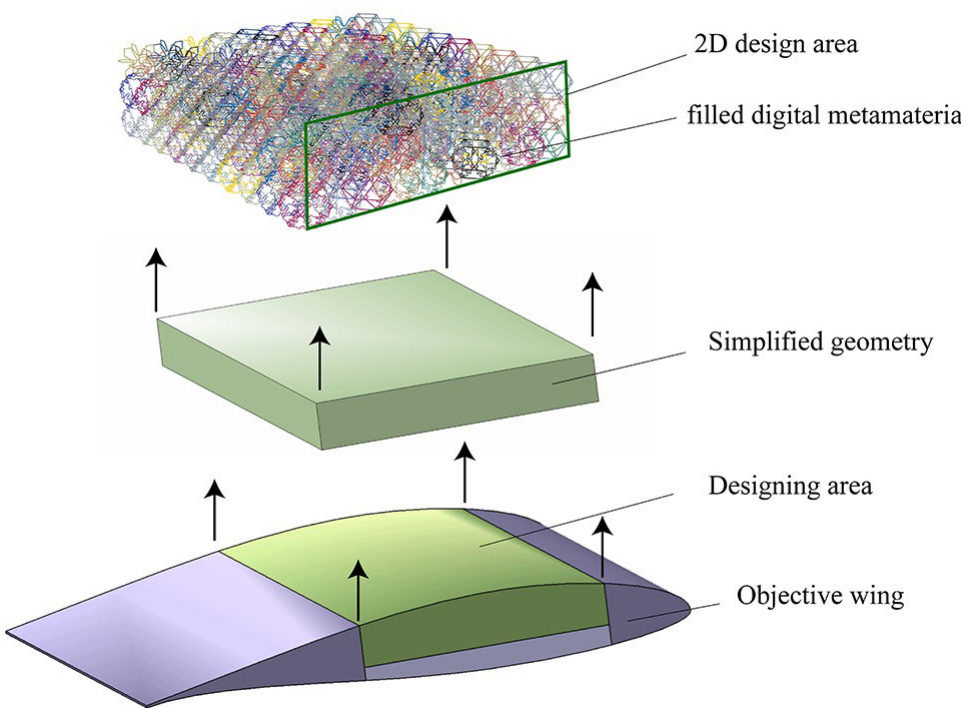
Figure 1. Schematic diagram of variable thickness wing based on digital metamaterial with varied cell geometries.